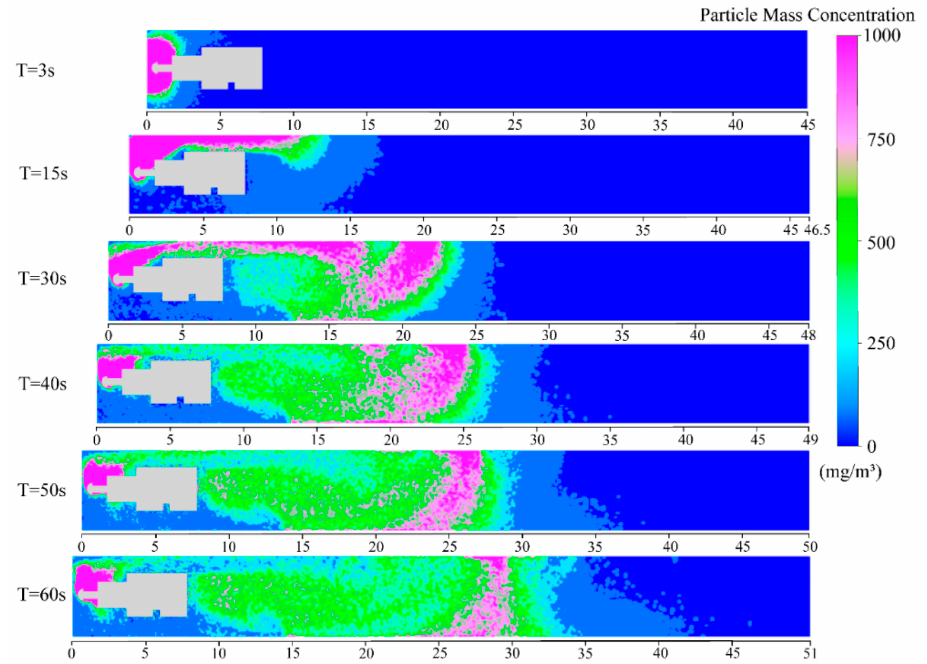
Figure 17. Simulation results of dust diffusion in the 1.5 m breathing zone (dynamic tunneling model).